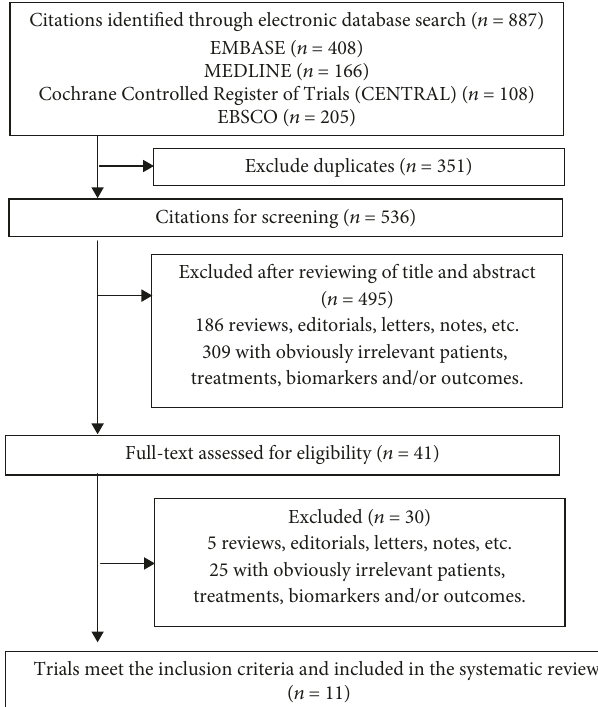
Figure 1: Flowchart of literature